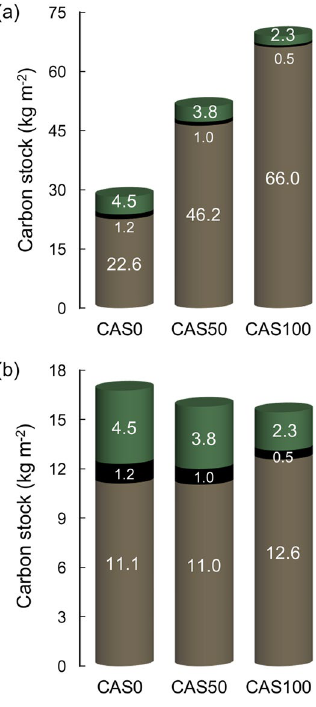
Figure 5. ( a ) C stocks accumulated since peat initiation and ( b ) the last 200 years (post-fire) in peat deposits (brown), tree belowground biomass (black), and tree aboveground biomass (green). Peat basal ages are 1255, 7667 and 7522 cal year BP for sites CAS0, CAS50 and CAS100, respectively. Tree minimal age is 180 years old for the three